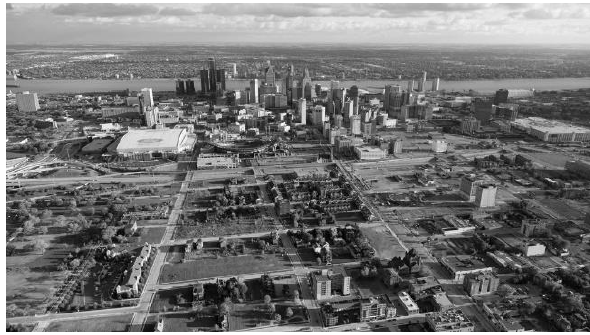
Figure 5. Detroit. From: Detroit by Air, by Alex S.